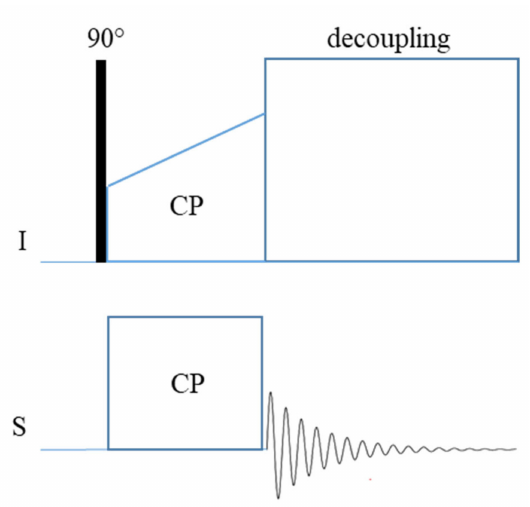
Figure 18. Cross polarization pulse sequence for the transfer of magnetization between an abundant spin (I) and a dilute spin